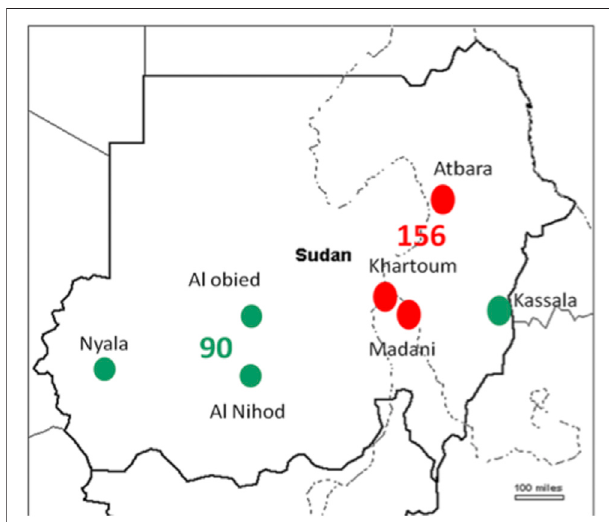
FIGURE 1 | The regions of Sudan where samples were obtained are depicted on the map, the red dots indicates endemic region, while the green ones indicates new extended regions.